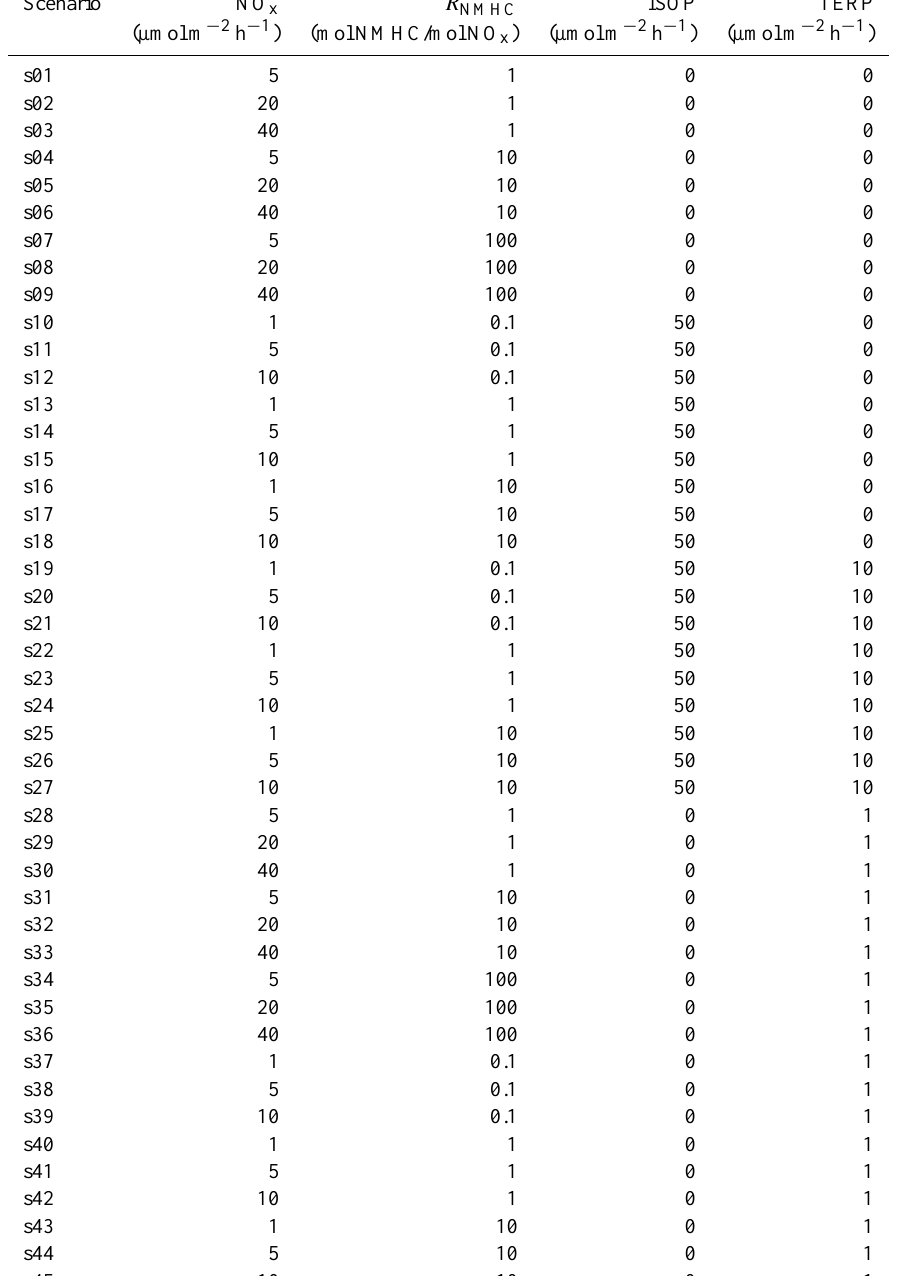
Table 2. Scenario Maximum Emission Rates ( E 0 ) for the Box Model Simulation Suite (hourly emission rate = E 0 × cos (θ z ) ; θ z = zenith